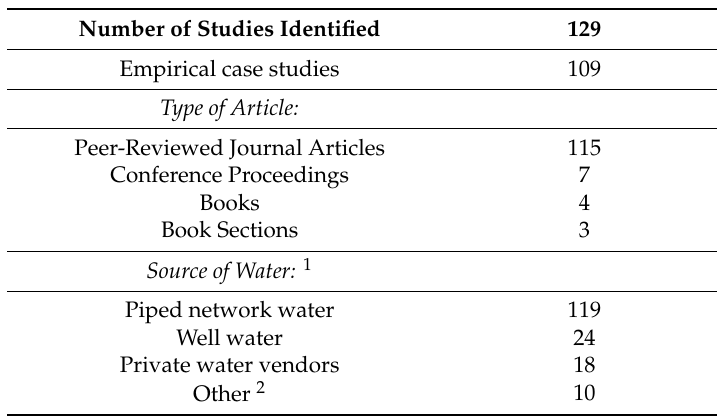
Table 1. Summary of Literature Search on Intermittent Water Supply.